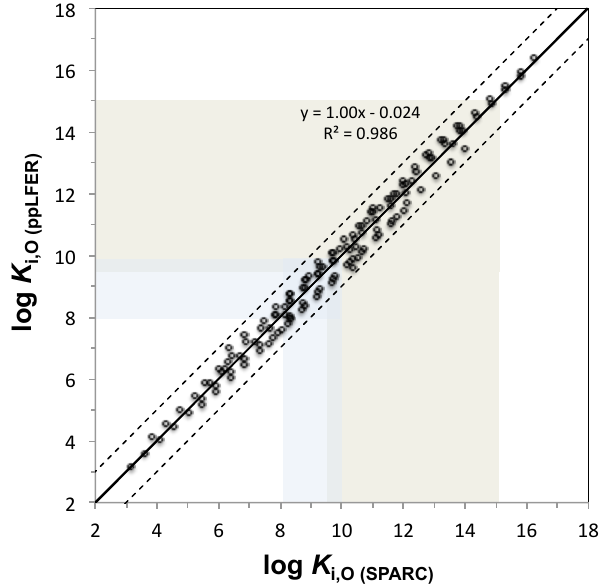
Figure 8. Plot comparing the partition coefficients at 25 ◦ C of alka- nes and their oxidation products between octan-1-ol and the gas phase predicted with SPARC and by polyparameter linear free en- ergy